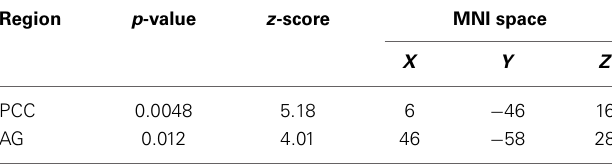
Table 1 | Negative correlation between Impulsivity Scale and DMN. Region p -value z -score MNI space X Y Z PCC 0.0048 5.18 6 − 46 16 AG 0.012 4.01 46 − 58 28 Cluster p-value and z-score and position, in MNI coordinates, of the voxel showing the maximum z-score value.